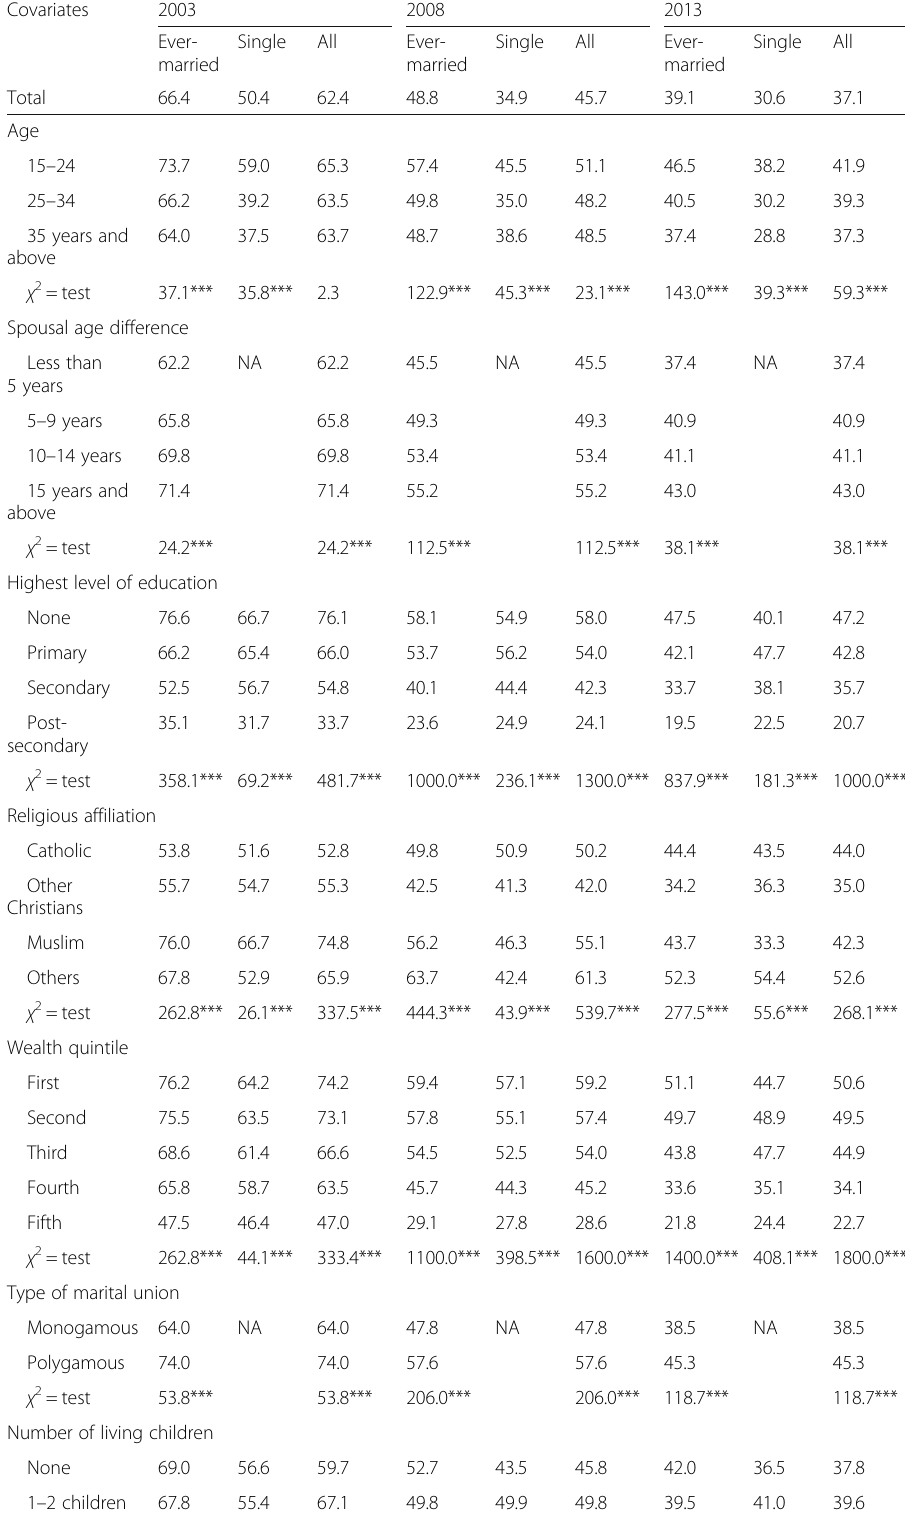
Table 2 Percent distribution of women who agreed that a husband is justified for beating his wife by marital status according to individual characteristics, 2003, 2008, and 2013 Nigeria Demographic and Health